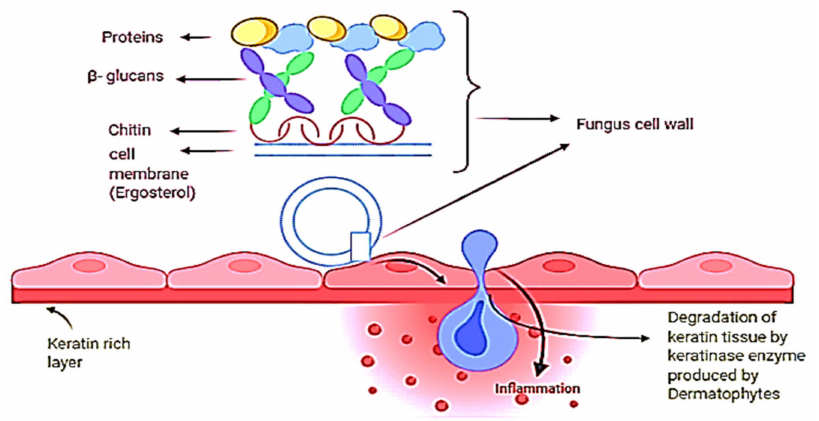
Figure 2. A possible mechanism for dermatophytosis. Dermatophytes are the fungi that need keratin for their growth; therefore, when a fungus cell invades the skin, it produces keratinase, an enzyme that feeds on the skin layer keratin, due to which keratin tissue degradation occurs and causes skin